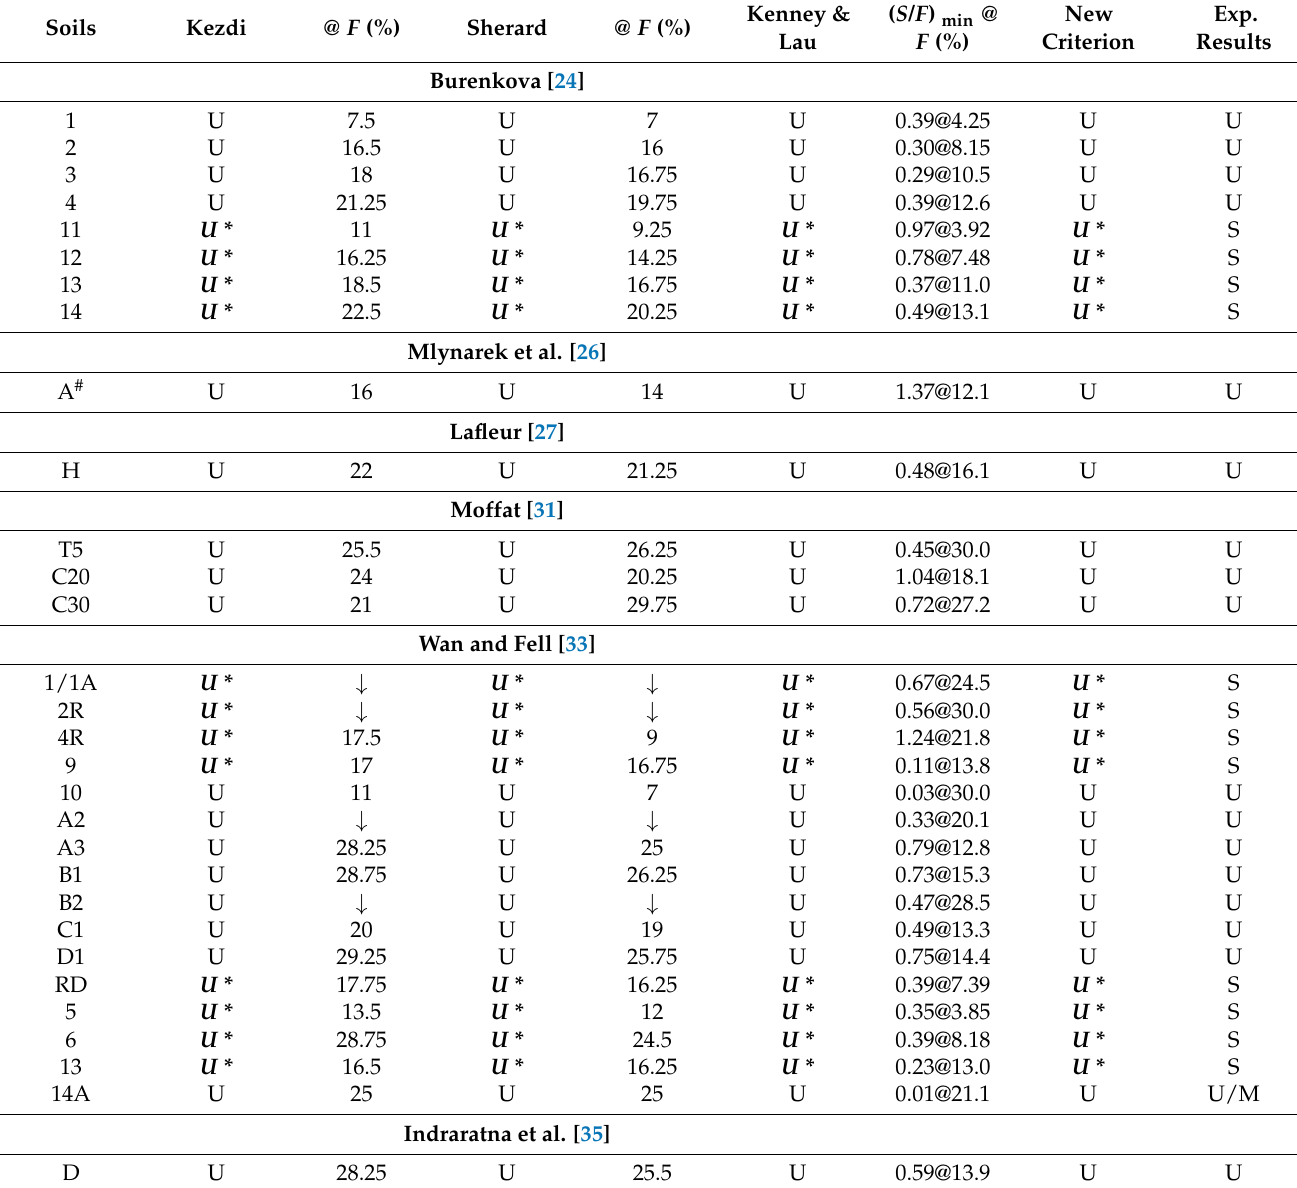
Table 2. Internal stability assessment of (clay)–silt–sand–gravel